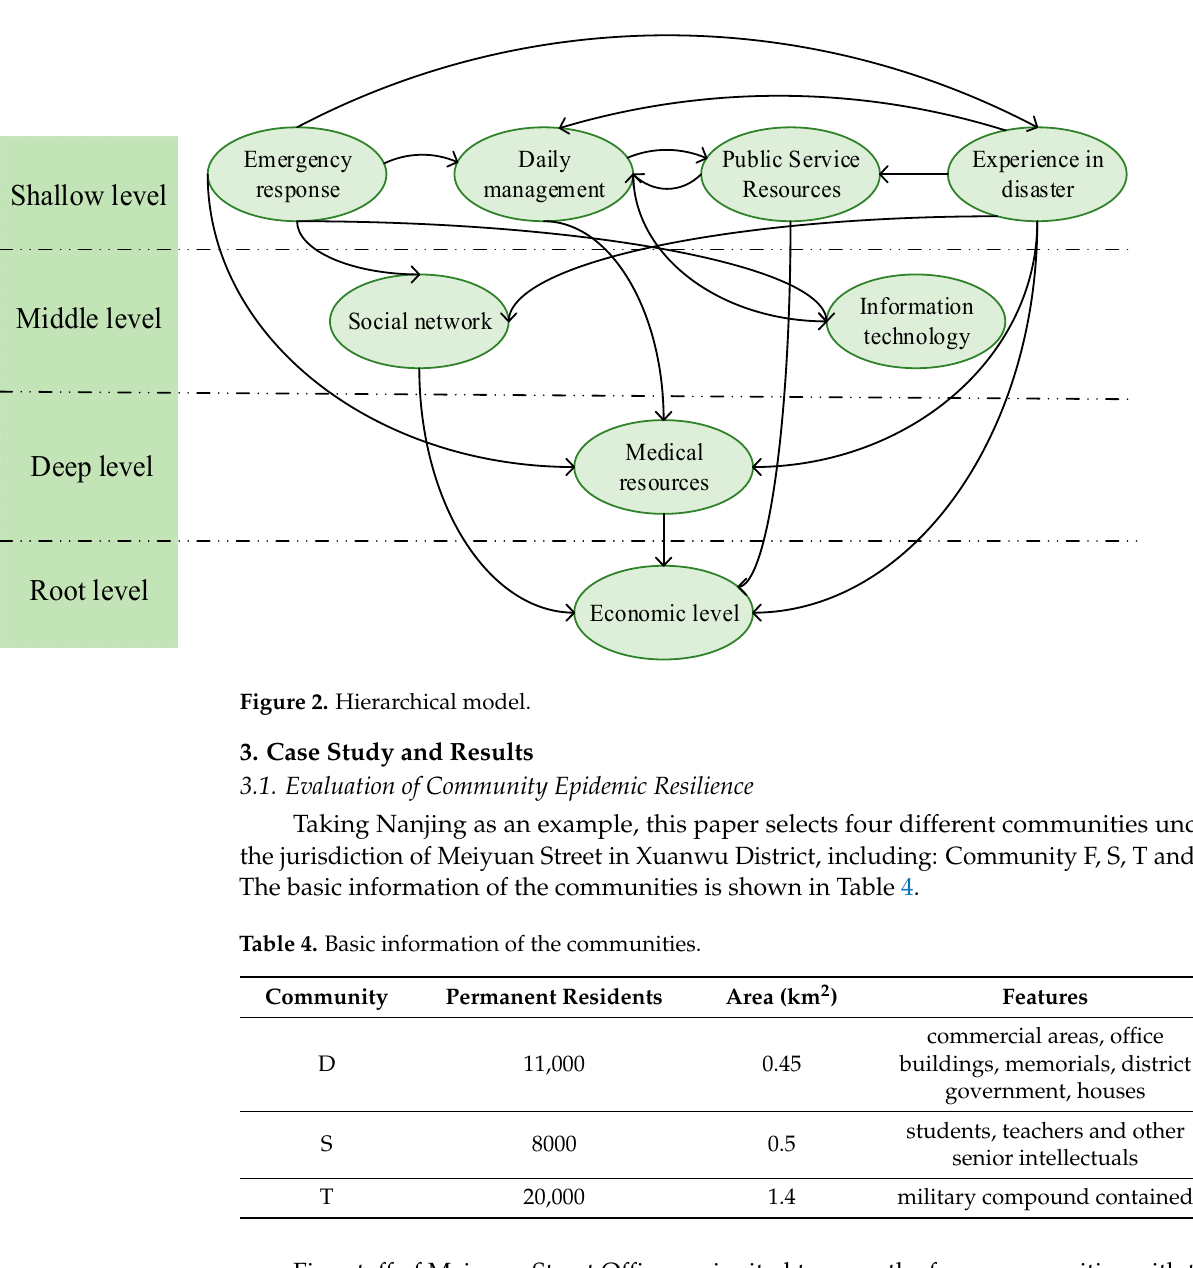
Table 4. Basic information of the communities.